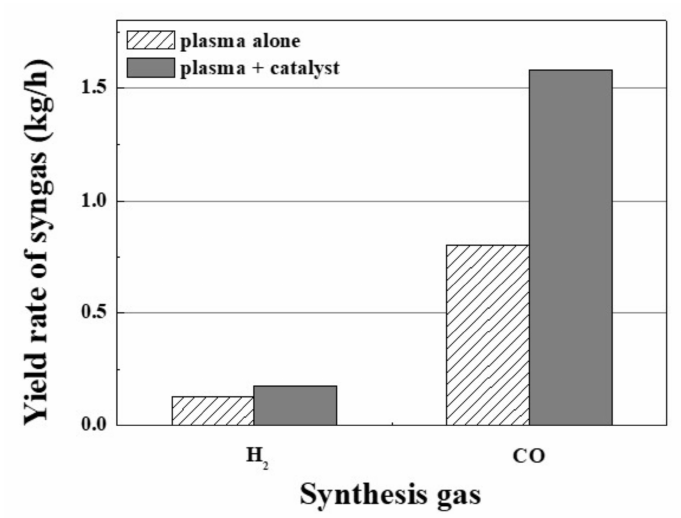
Figure 7. Syngas yield rates obtained using the hybrid system.